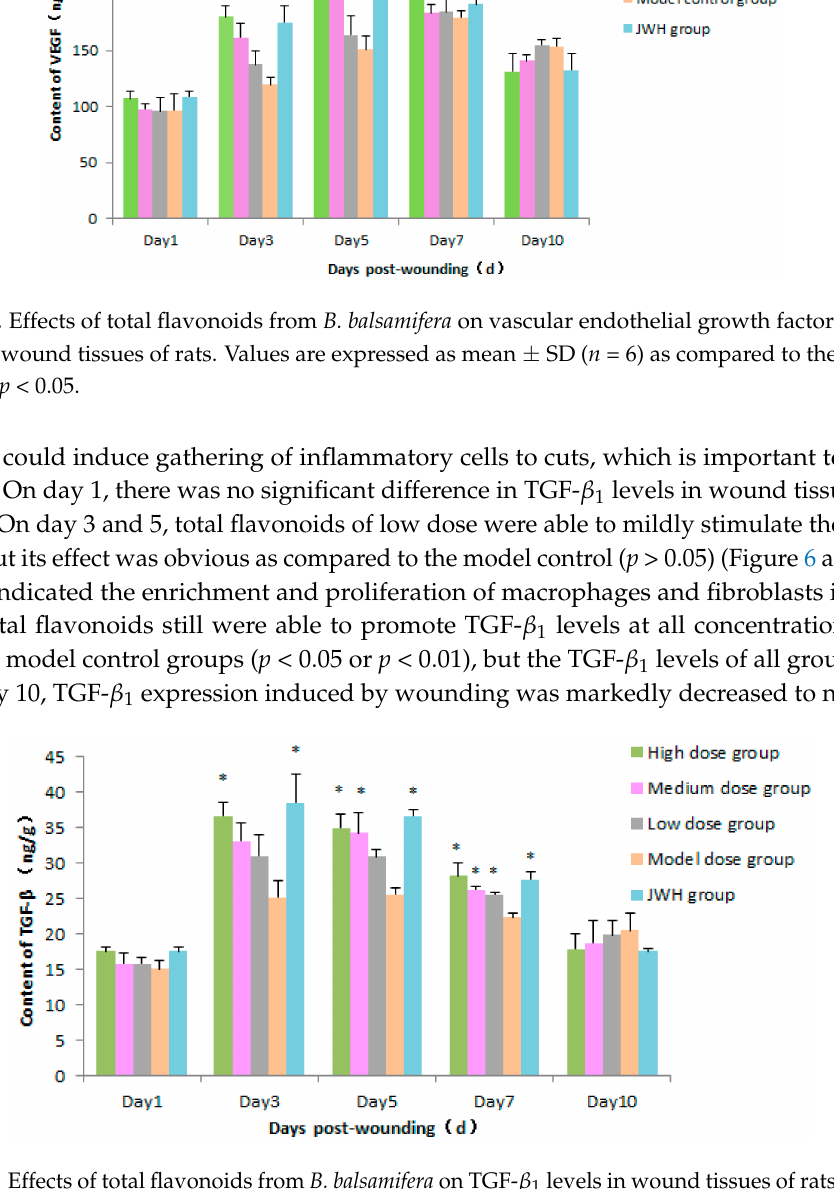
Figure 6. Effects of total flavonoids from B. balsamifera on TGF- β 1 levels in wound tissues of rats. Values are expressed as mean ± SD ( n = 6) as compared to the control group, * p <